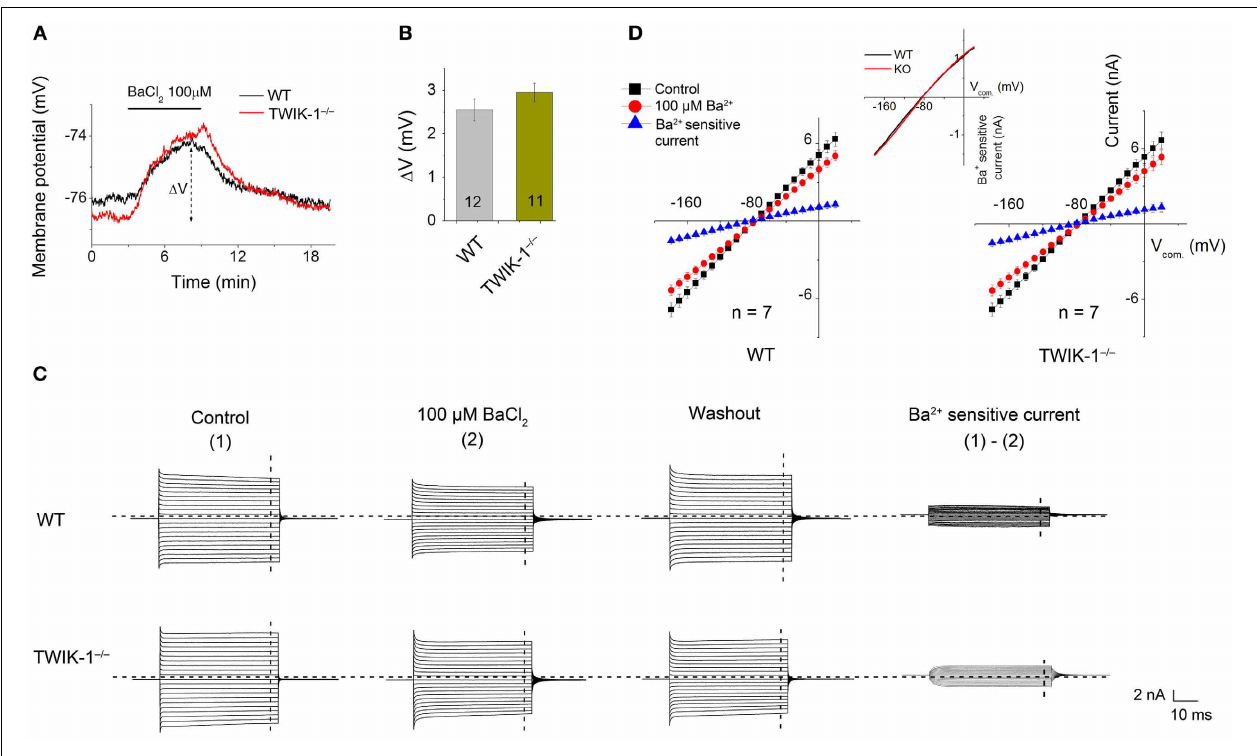
after 5min 100 μ M BaCl 2 application. I–V relationships were shown in (D) . The Ba 2 + sensitive currents were obtained from sweep subtraction. The Ba 2 + sensitive currents were shown in expanded y-axis in the inset in (D) that showed a moderate inward rectification in both WT, RI = 0.86, and TWIK-1 − / − , RI = 0.87, astrocytes. Data are shown as mean ± SEM. Numbers of experiments are given in the